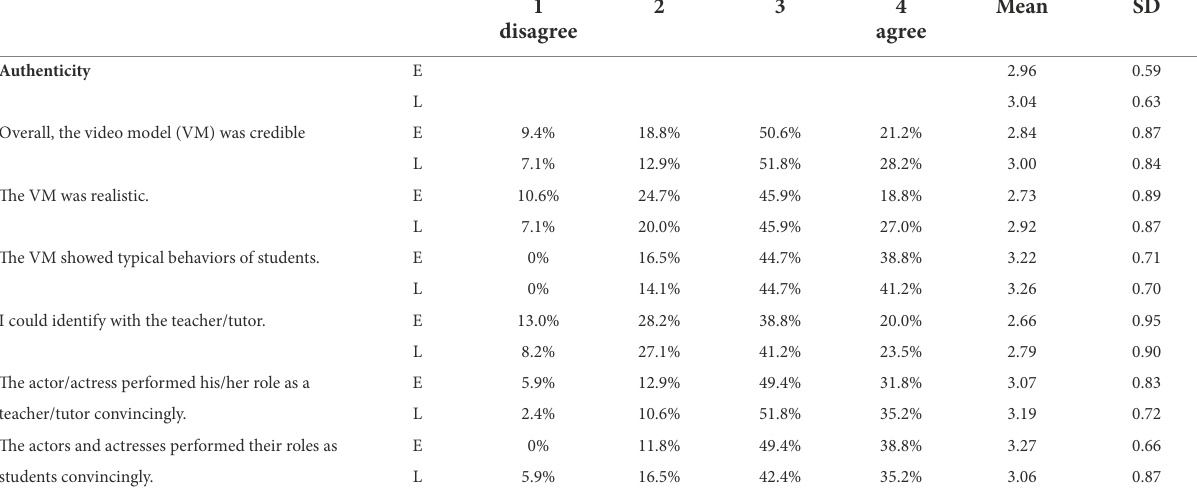
TABLE 2 User experience of authenticity as indicator for realistic practice